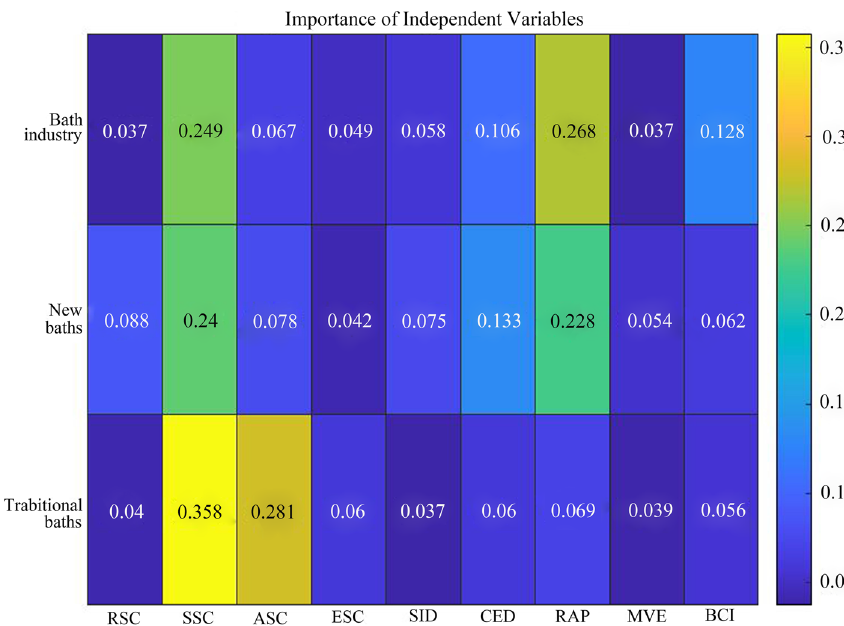
Fig. 5 Heat map of the importance of independent